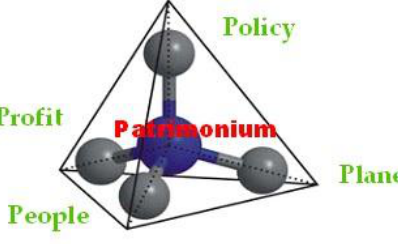
Figure 3. The tetrahedron presentation of sustainable development (SD) of Patrimony (heritage).